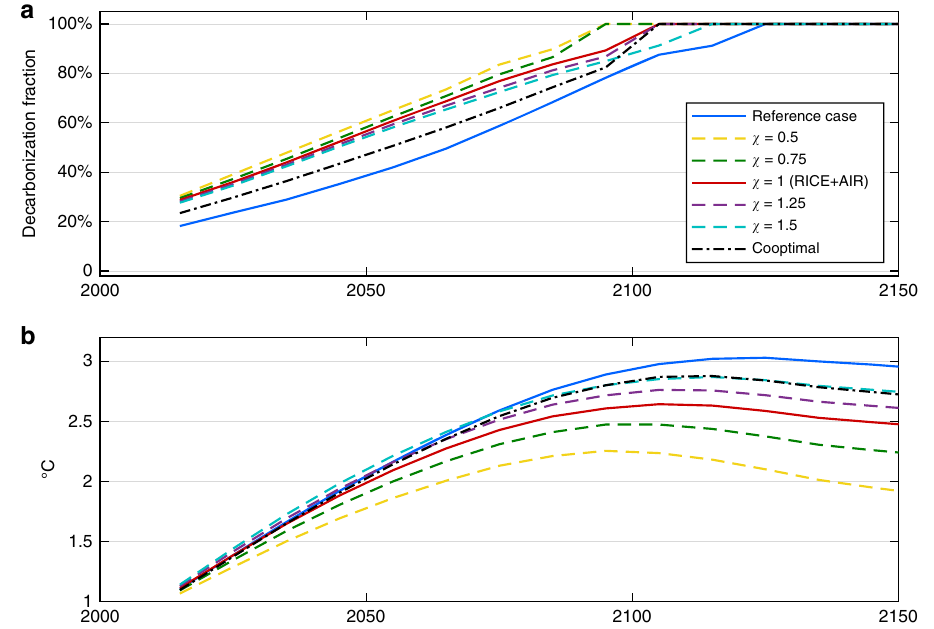
Fig. 4 Impact of independent air quality control. a Optimal decarbonization and b associated global temperature rise given different levels of autonomous air quality control. The reference and RICE + AIR cases from Fig. 1, where χ = 1, are displayed as the blue and red solid lines,